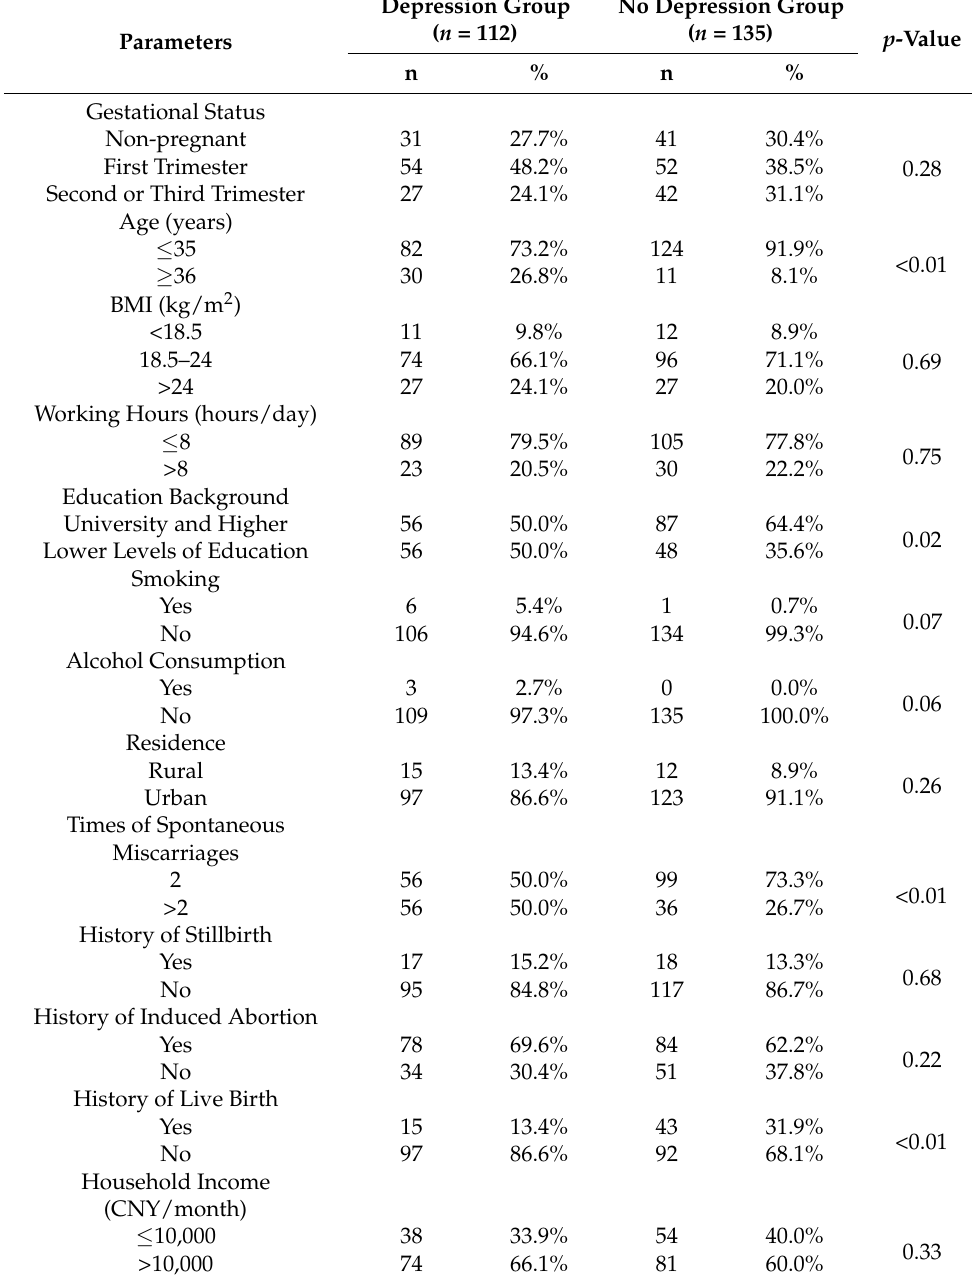
Table 2. Univariable analysis of risk factors of self-reported depression for RPL patients.